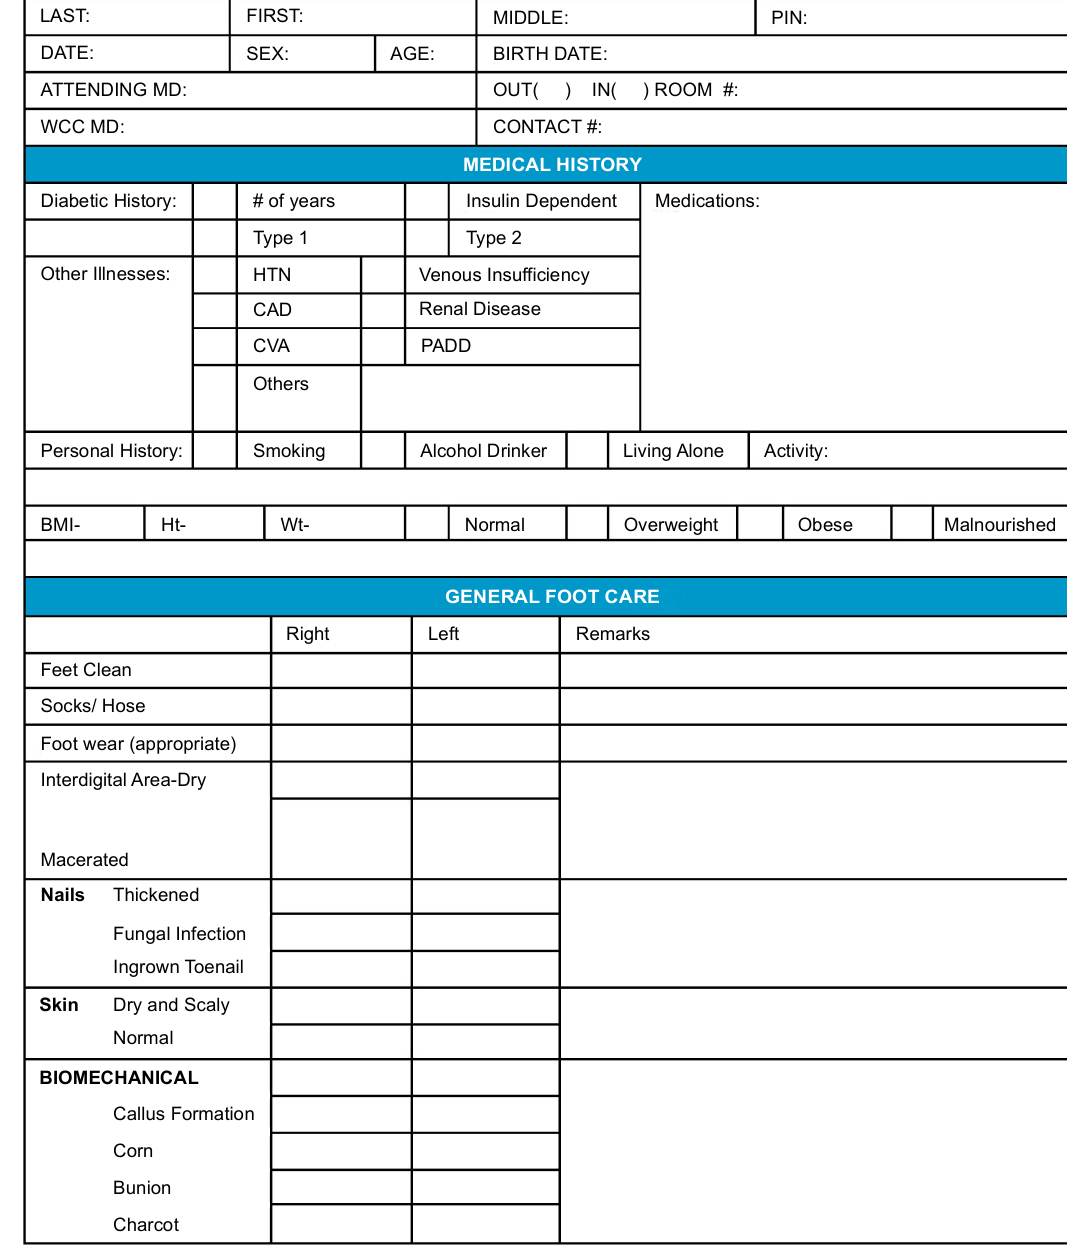
Venous Insufficiency Renal Disease PADD